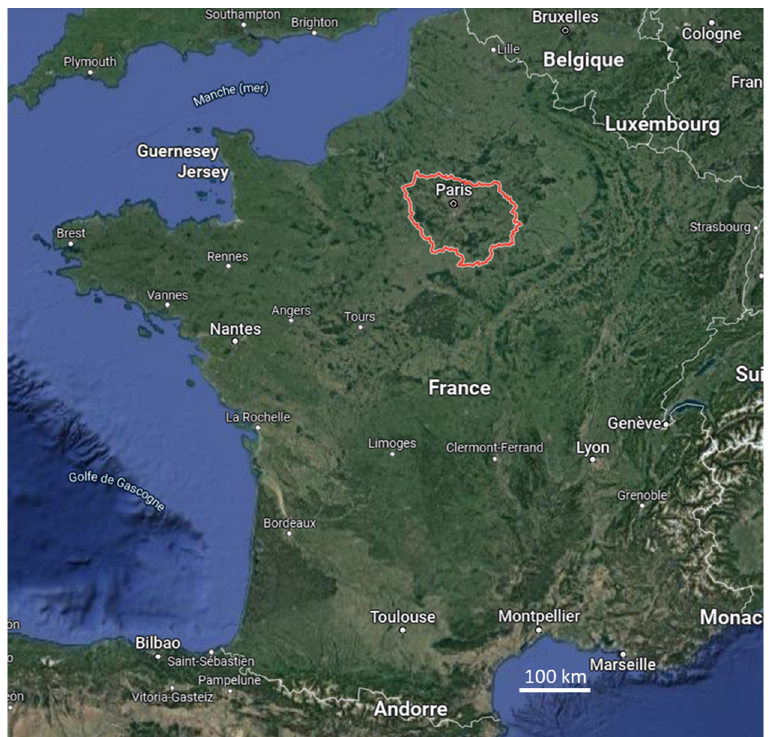
Figure 3. Geographic location of the Ile-de-France department and Paris Basin region as studied in STRATEGY CCUS project. Copyright: Google images @2022. Geographic National Institute of France.